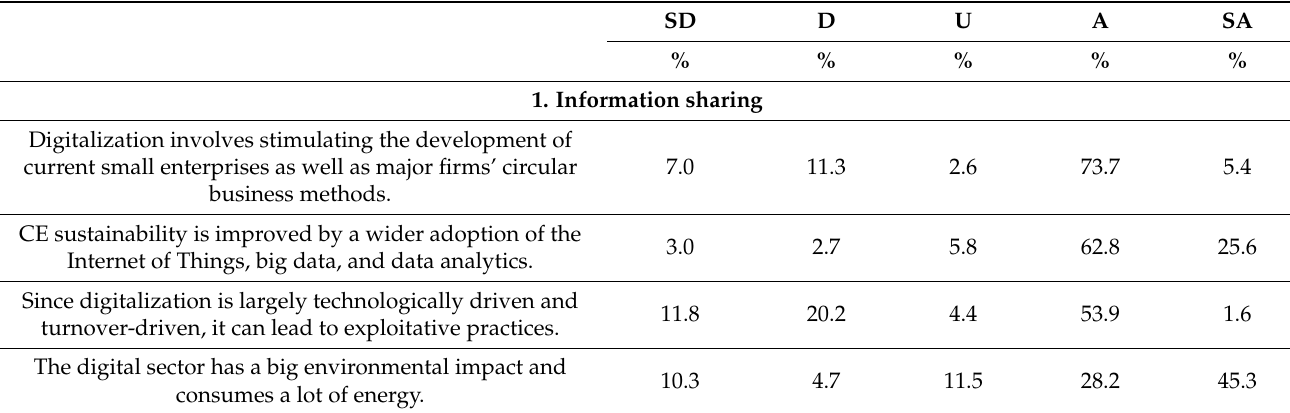
Table 3. Results on digital practices for sustainability.